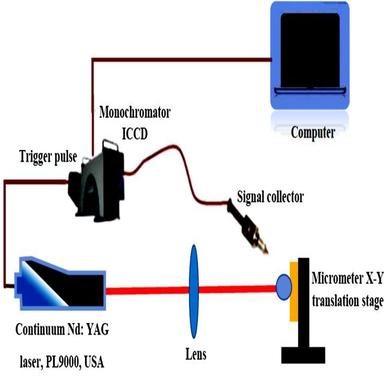
Laser-induced breakdown spectroscopy (LIBS) experimental setup.